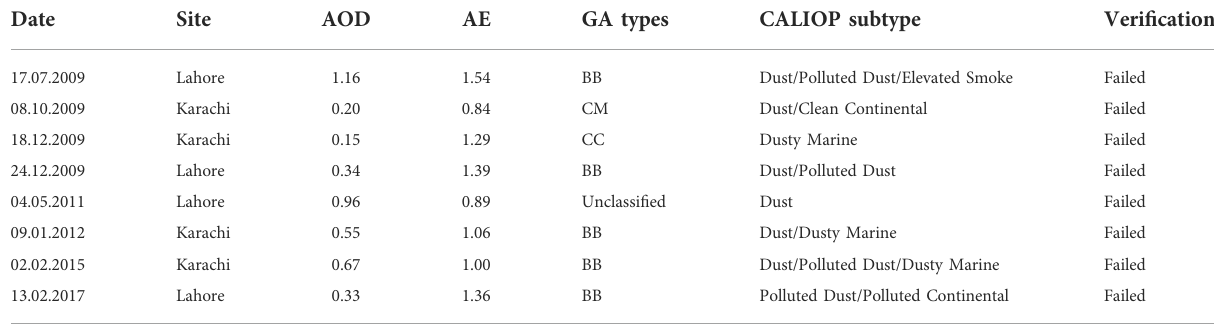
TABLE 5 Veri fi cation of GA aerosol types against CALIOP aerosol subtypes over the Lahore (31.48 ° N, 74.264 ° E) and Karachi (24.946 ° N, 67.136 ° E) AERONET sites located in